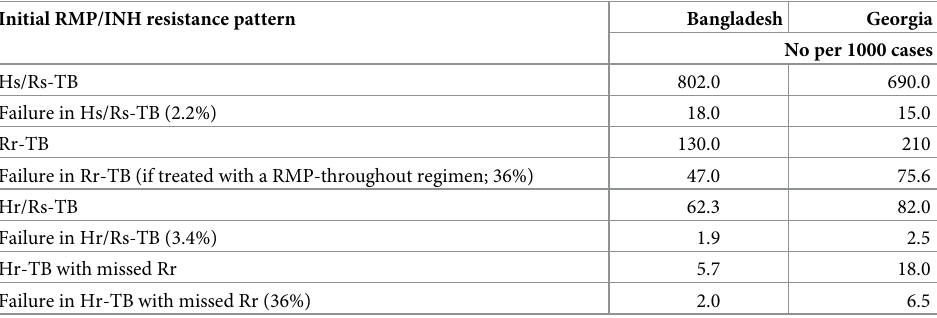
Table 6. Effect of missed rifampicin resistance on treatment outcomes in patients with isoniazid resistance treated with a first-line regimen, in a setting with high (21%, Georgia) and low (13%, Bangladesh) rifampicin resistance prevalence (combined, new and retreatment cases together at the same